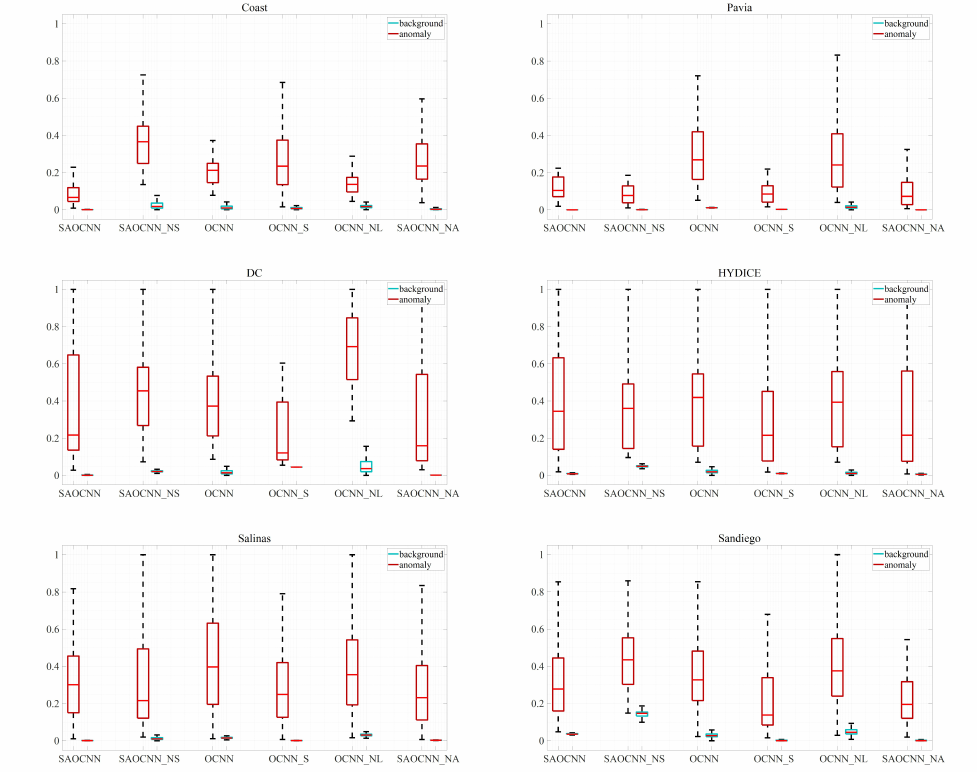
Figure 12. Box plot of ablation